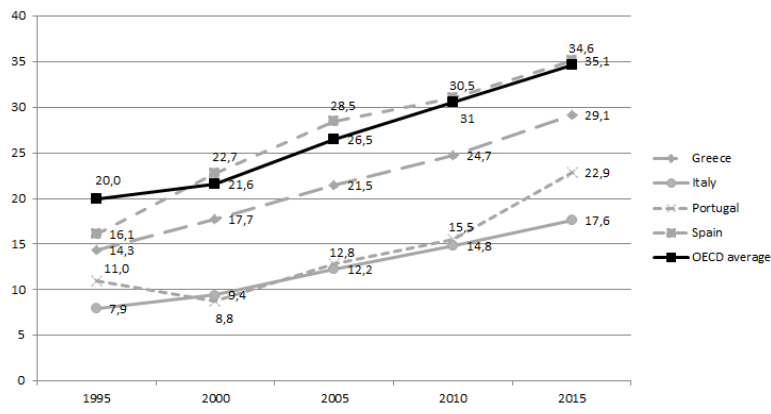
Figure 1: Percentage of the 25-64-year-old population with tertiary education,